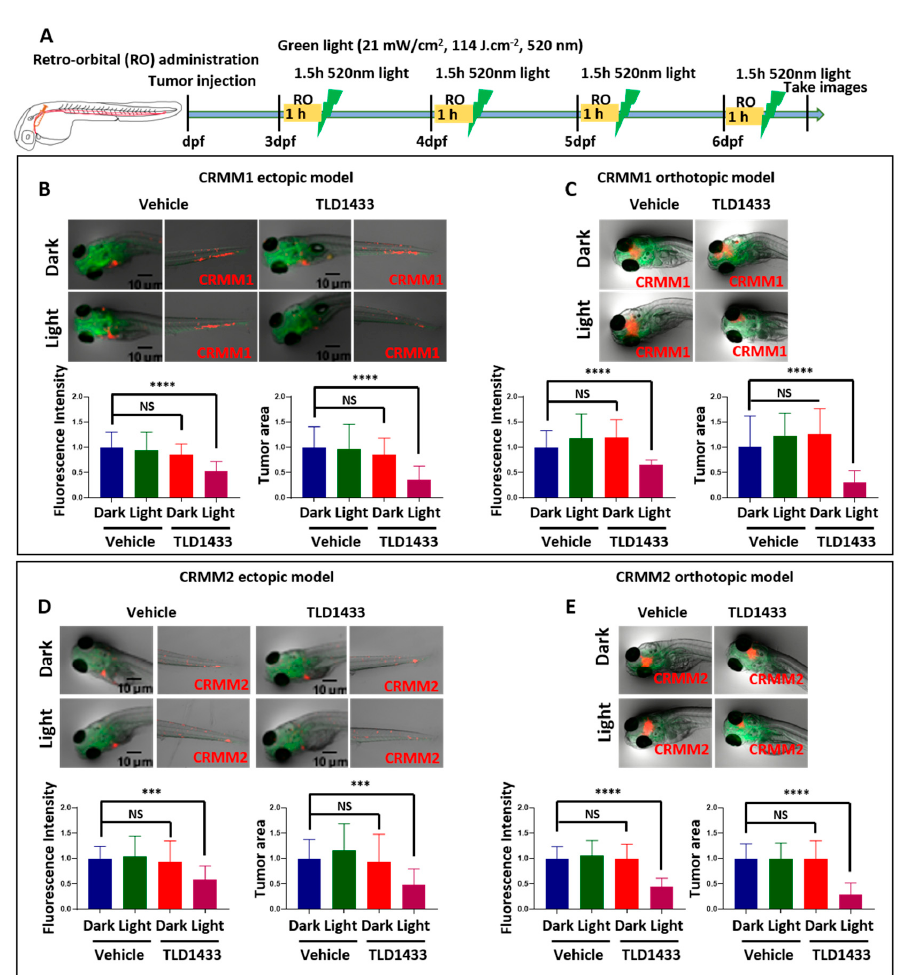
Figure 9. TLD1433 treatment by RO administration in the zebrafish ectopic and orthotopic CM model. ( A ) Schedule of tumour injection and TLD1433 administration in zebrafish embryos. Relative tumour burdens were calculated as described in Figure 7. ( B ) CRMM1 tumour burden in the ectopic model ( n ≈ 30). ( C ) CRMM1 tumour burden in the orthotopic model ( n ≈ 15). ( D ) CRMM2 tumour burden in the ectopic model (n ≈ 30). ( E ) CRMM2 tumour burden in the orthotopic model ( n ≈ 15). Results are presented as means ± SD from three independent experiments. Representative images show CM tumour burden in the head and tail regions in ectopic model and localised tumour in orthotopic model. 2.5. TLD1433 by Retro Orbital Administration Induces Apoptosis of CRMM1 and CRMM2 Cells in Table 3. Relative tumour burden quantified by fluorescence intensity in zebrafish embryonic models after treatment with TLD1433, delivered by three different administration routes. The fluorescence intensity is calculated as percentage, compared to the control dark group (100%).